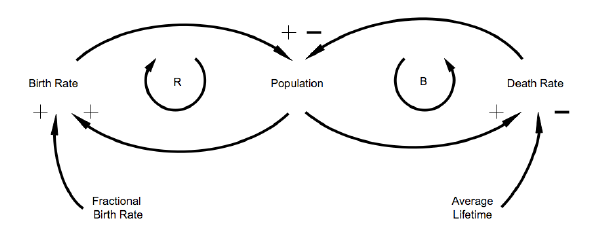
Figure 3. Example of an SFD (source: Richmond, 2001, p.